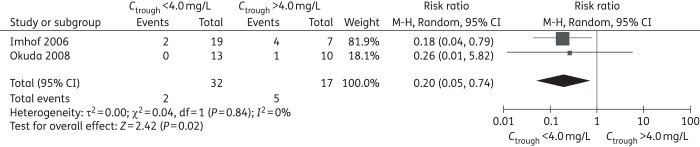
Meta-analysis for incidence of neurotoxicity (trough concentration of <4.0 mg/L comparison with >4.0 mg/L, RR <1 favours Ctrough <4.0 mg/L).